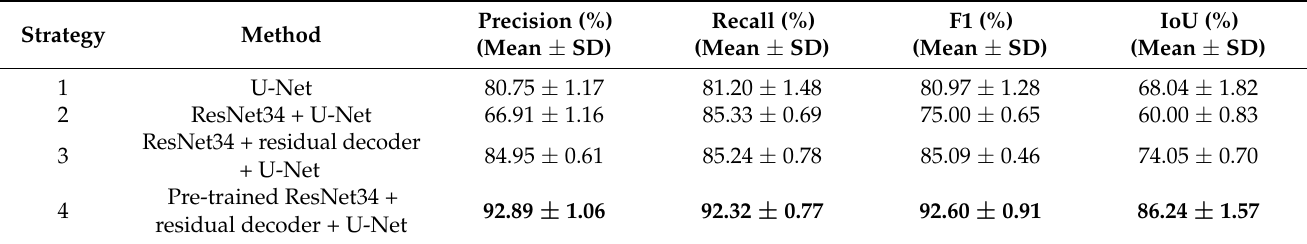
Table 5. Precision, Recall, F1, and IoU of the models (Mean ± SD 1